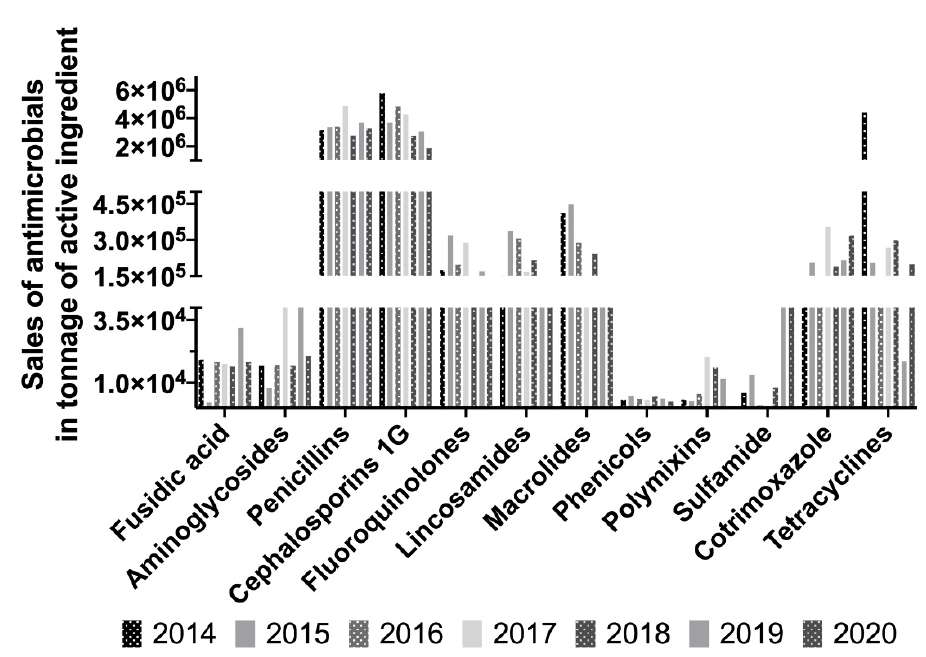
Figure 6. Evolution of antimicrobial sales in tonnage of active ingredient for each antimicrobial class.